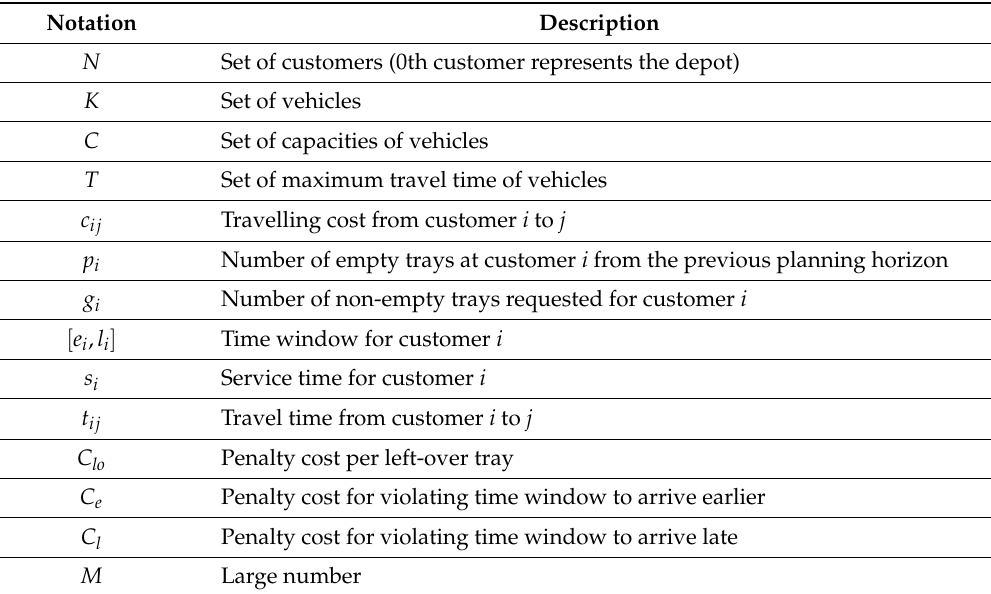
Table 1. Notations and